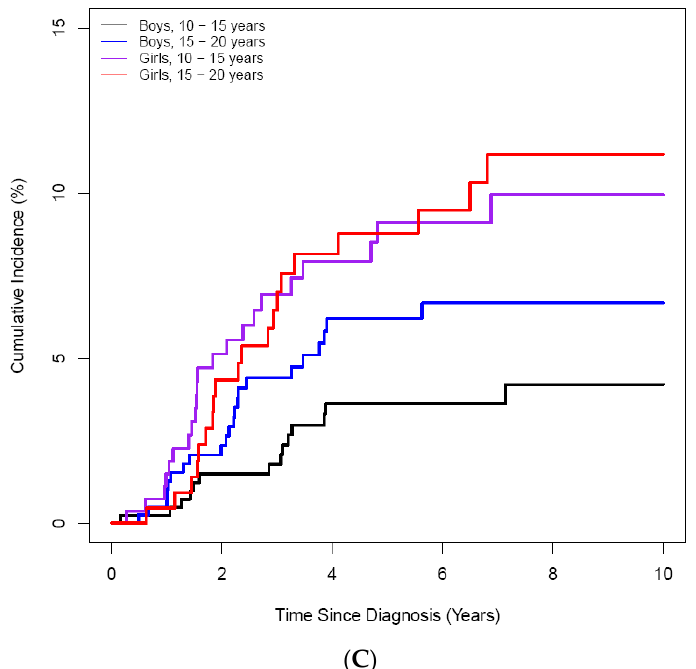
Figure 3. Cumulative incidence of ON according to age at the diagnosis of ALL/LBL in 4861 patients. ( A ) A 10-year scale, ( B ) 5-year scale (C) by age and sex. ( A ) During 10–20-years, the highest CI was noted, and during 15–20 years, patients had the highest CI ( B ). Girls showed higher CI than boys ( C ).